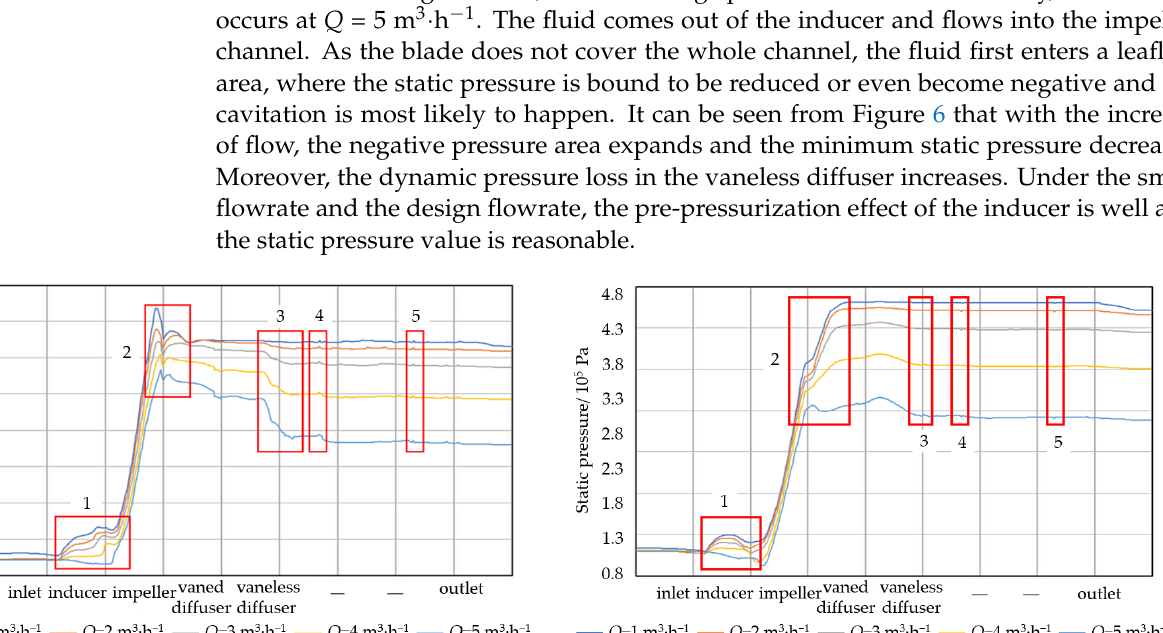
Figure 5. Comparison between numerical simulation results and experimental data.